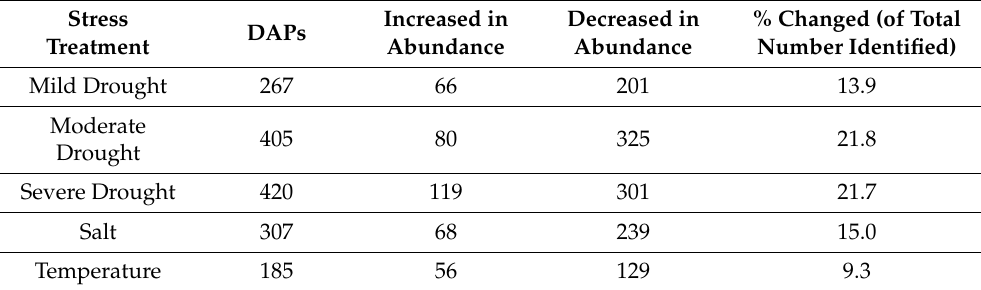
Table 2. Differentially abundant proteins (DAPs) under individual abiotic stresses in Nipponbare.